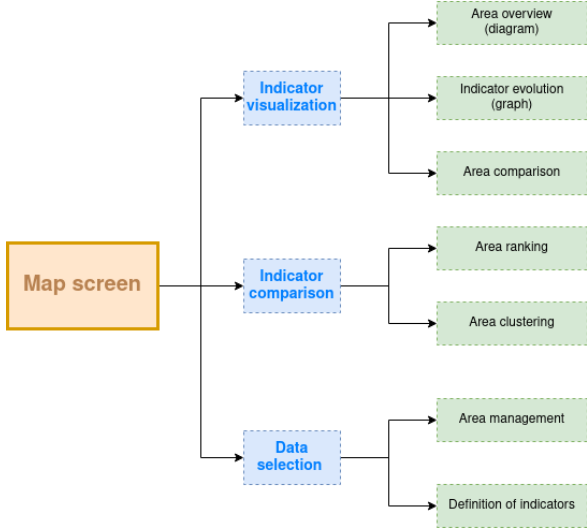
Figure 2. Functional view of